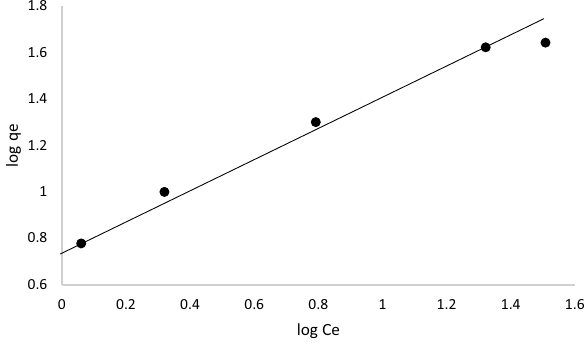
Fig. 10 Freundlich adsorption isothermal plot for the adsorption of Rh-B on AgNPs